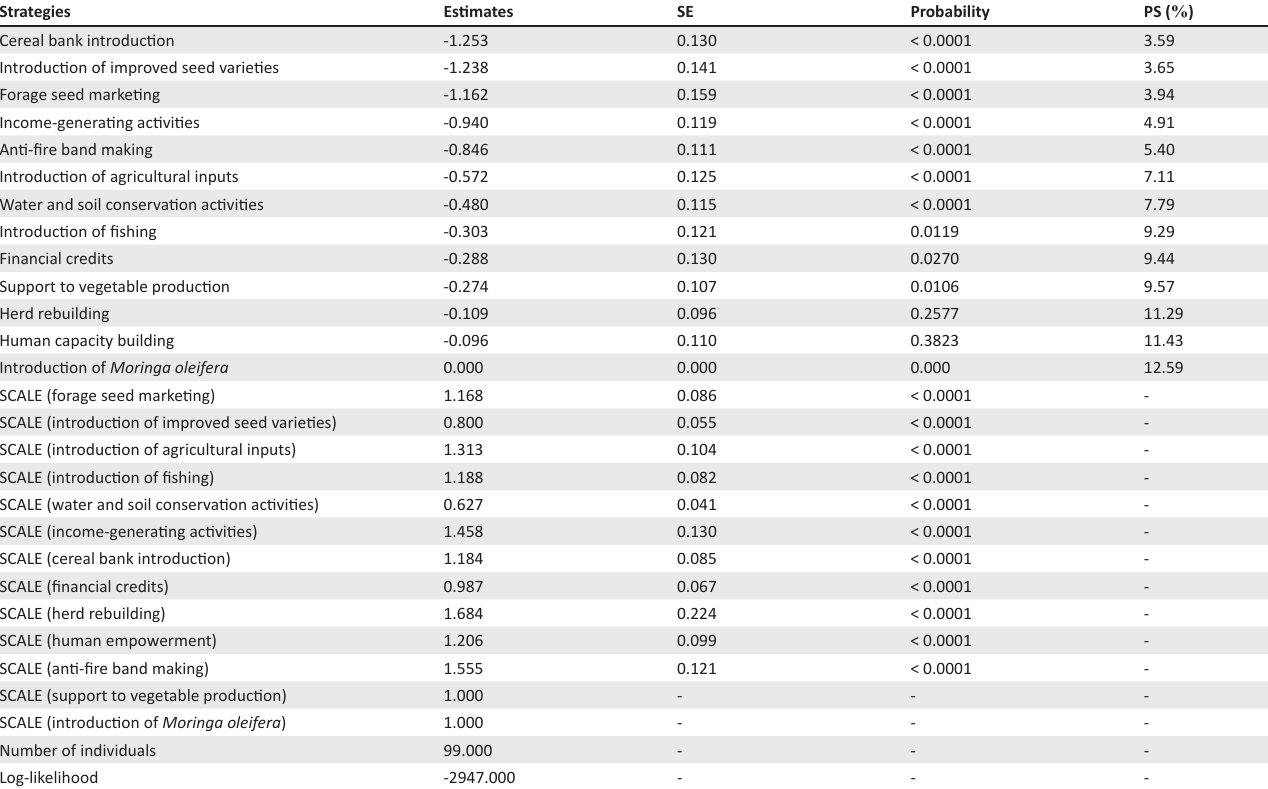
TABLE 4: Farmers’ utility for new climate change adaptation strategies based on the heteroscedastic (HEV) extreme estimates.